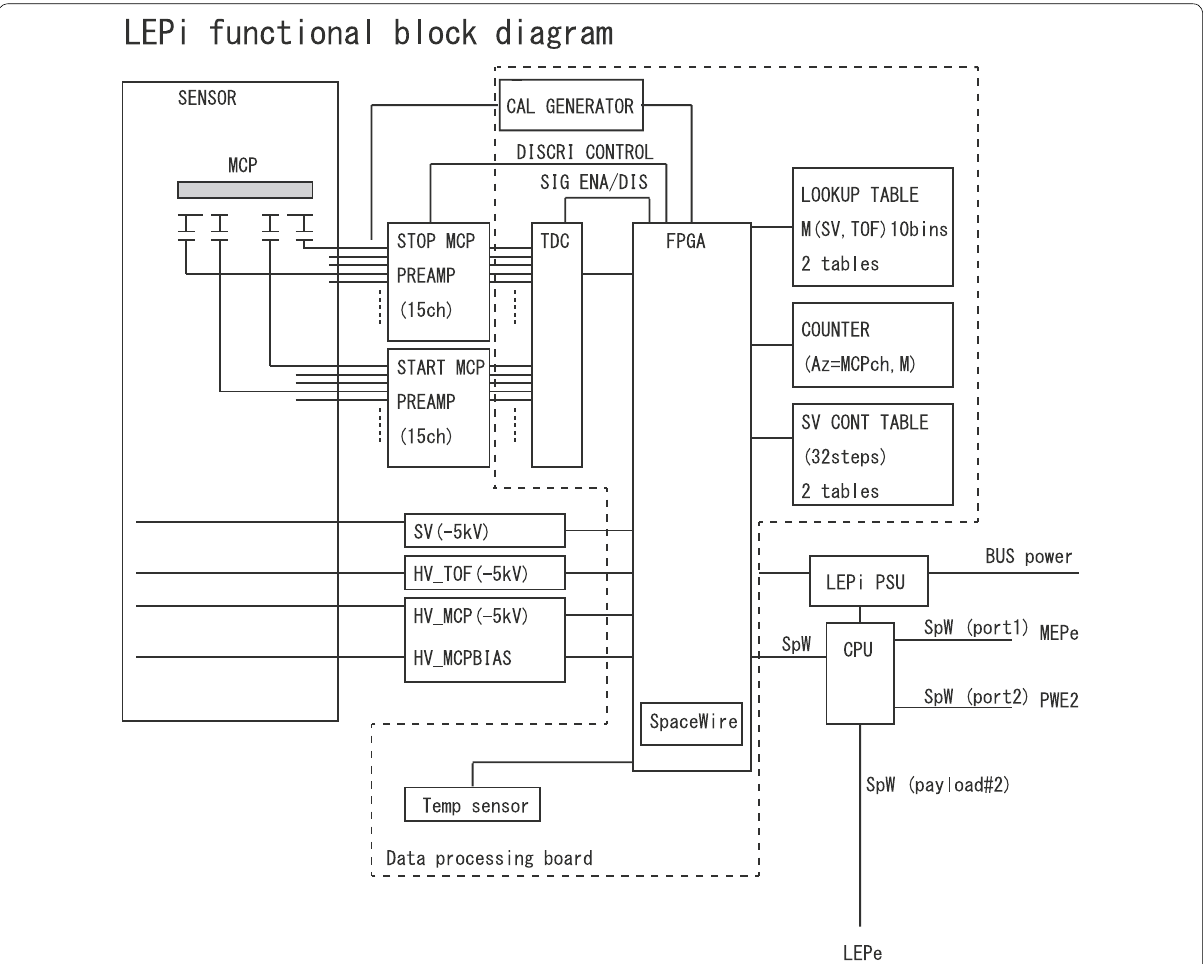
Fig. 4 A functional block diagram of LEPi. MEPe indicates the CPU board of the MEPe instrument. PWE2 indicates one of the CPU boards of the plasma wave experiment (PWE) (Kasahara et al. 2018b). Output data of LEPi are sent to the data recorder via port1 or